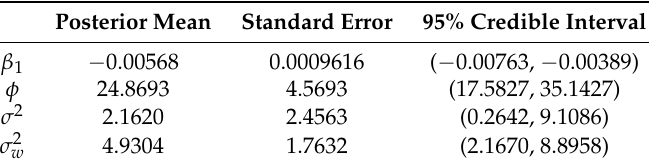
Table 3. Posterior estimation under the best